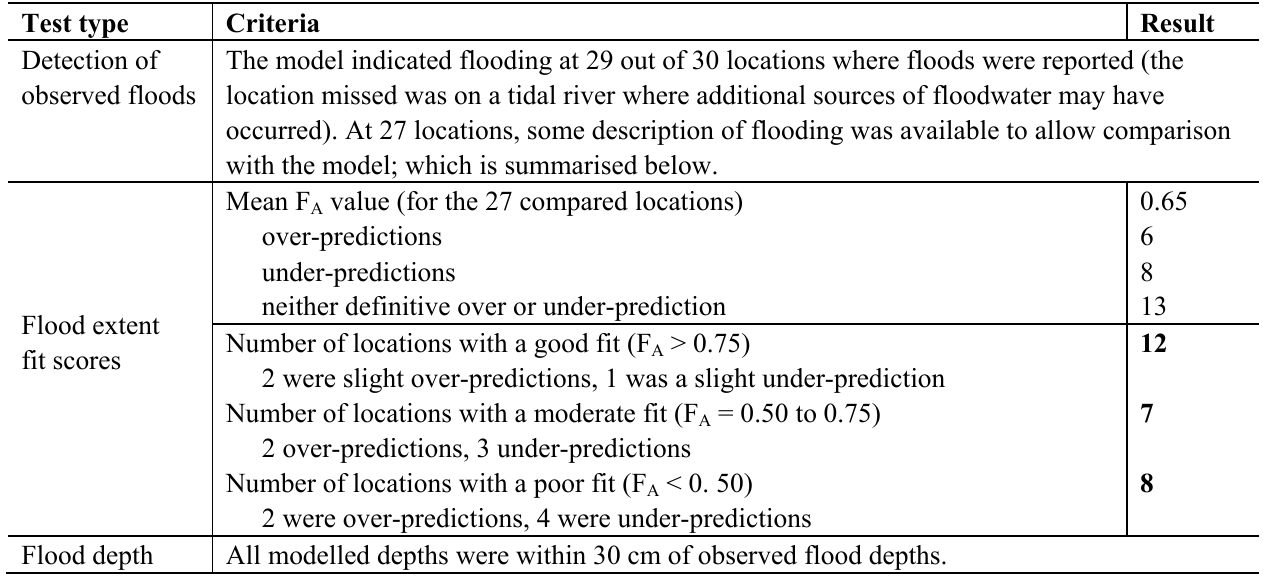
Table 3. Summary of the 10th March 2008 model